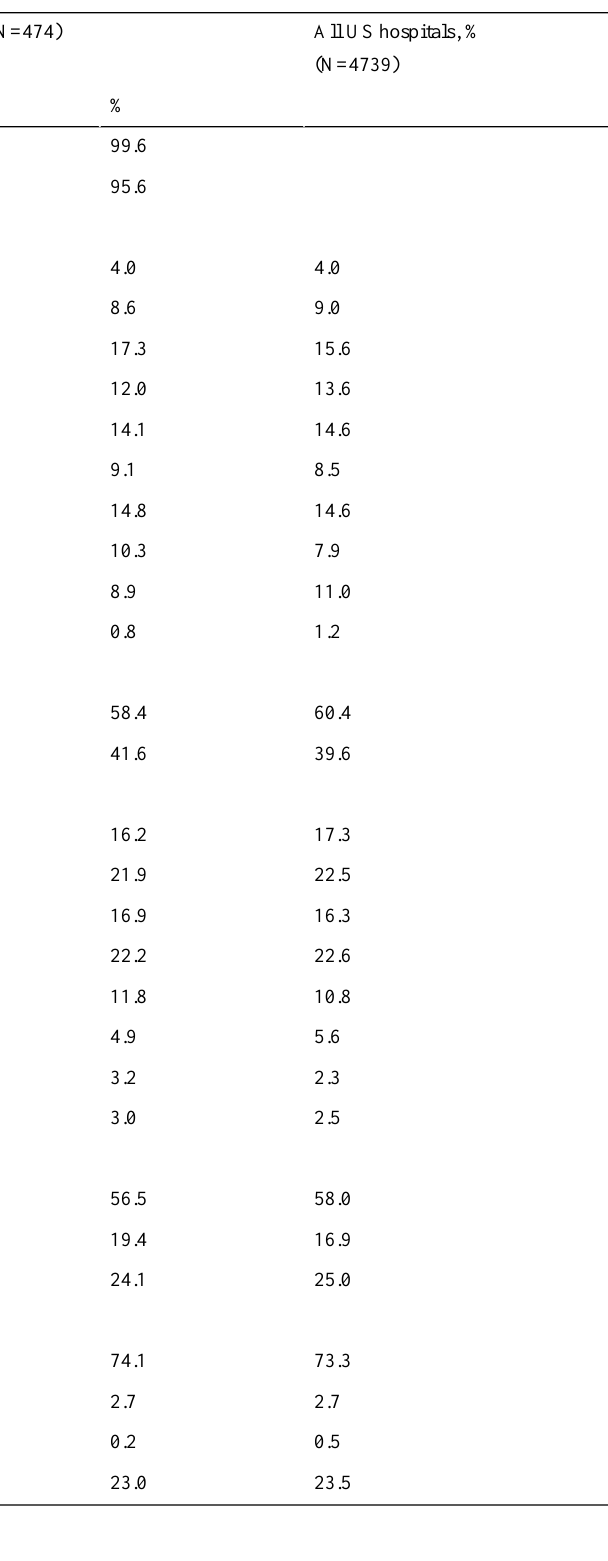
Table 1. Summary statistics of the hospitals included in this